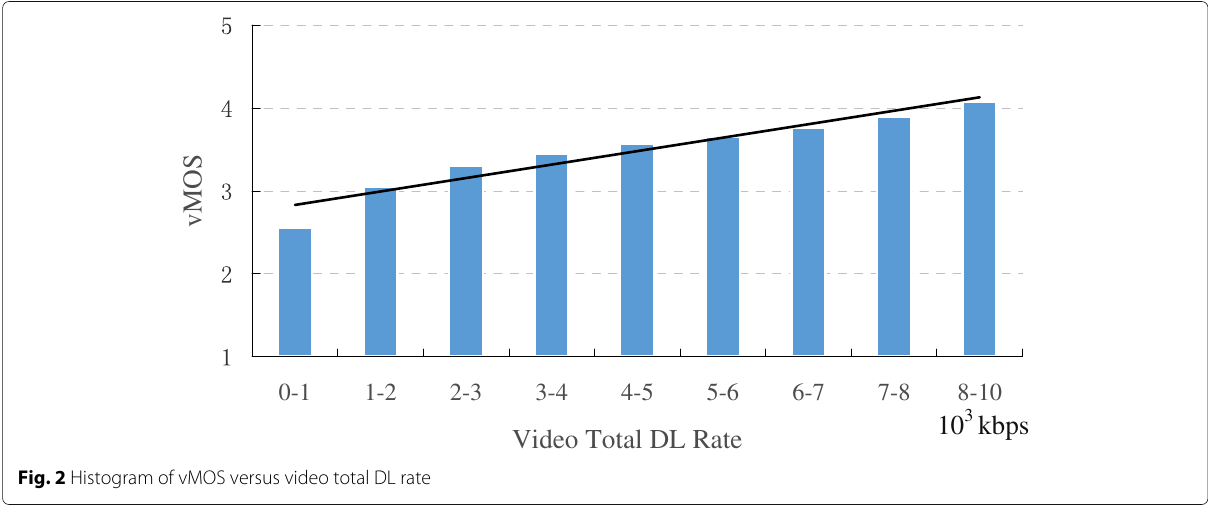
Fig. 2 Histogram of vMOS versus video total DL rate